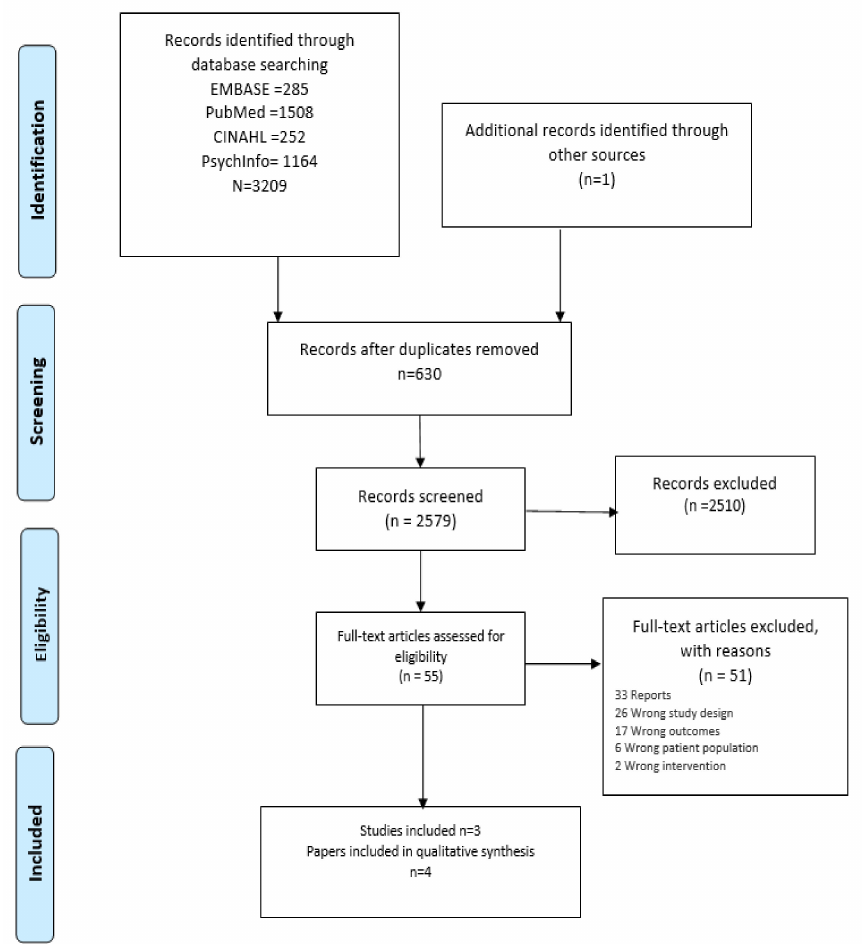
Figure 1. PRISMA 2009 Flow